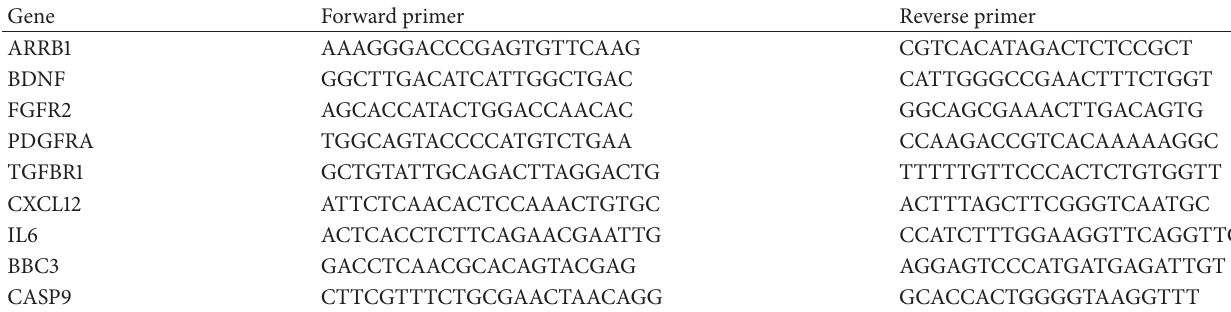
Table 2: Primers used for quantitative real-time polymerase chain